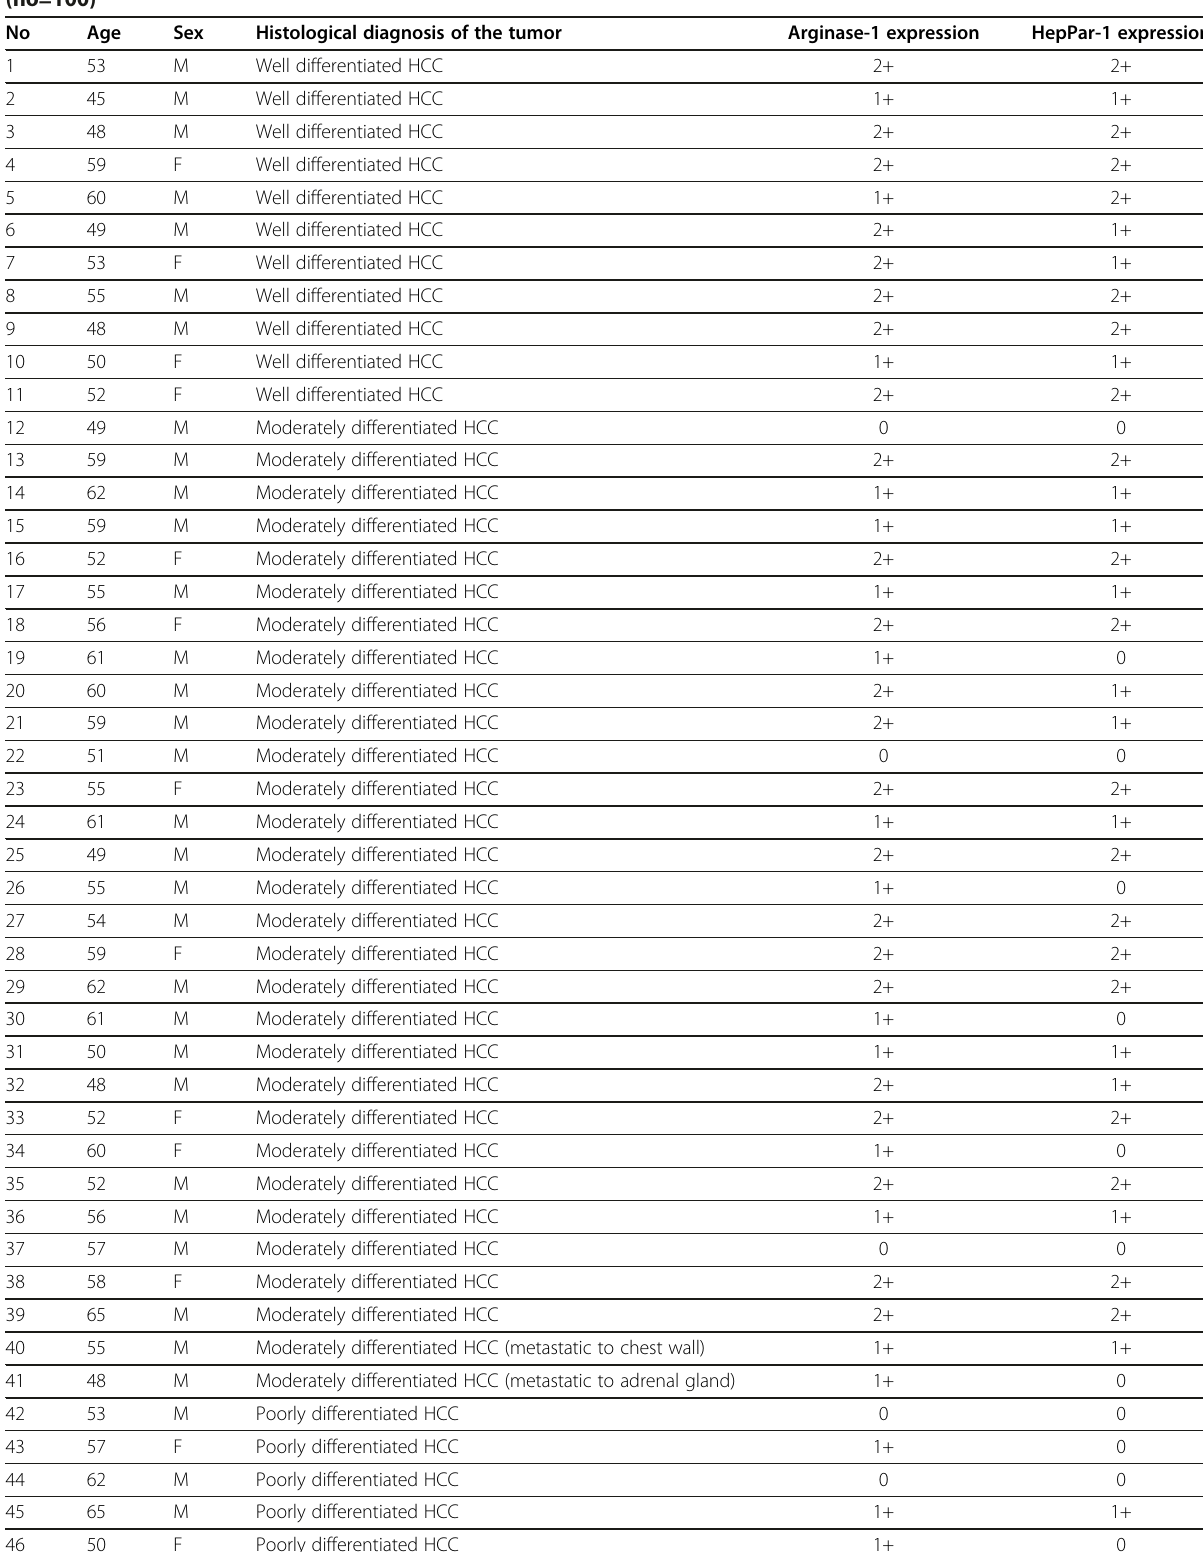
Table 1 Clinicopathological features and the expressions of arginase-1 & HepPar-1 in all studied tumorous